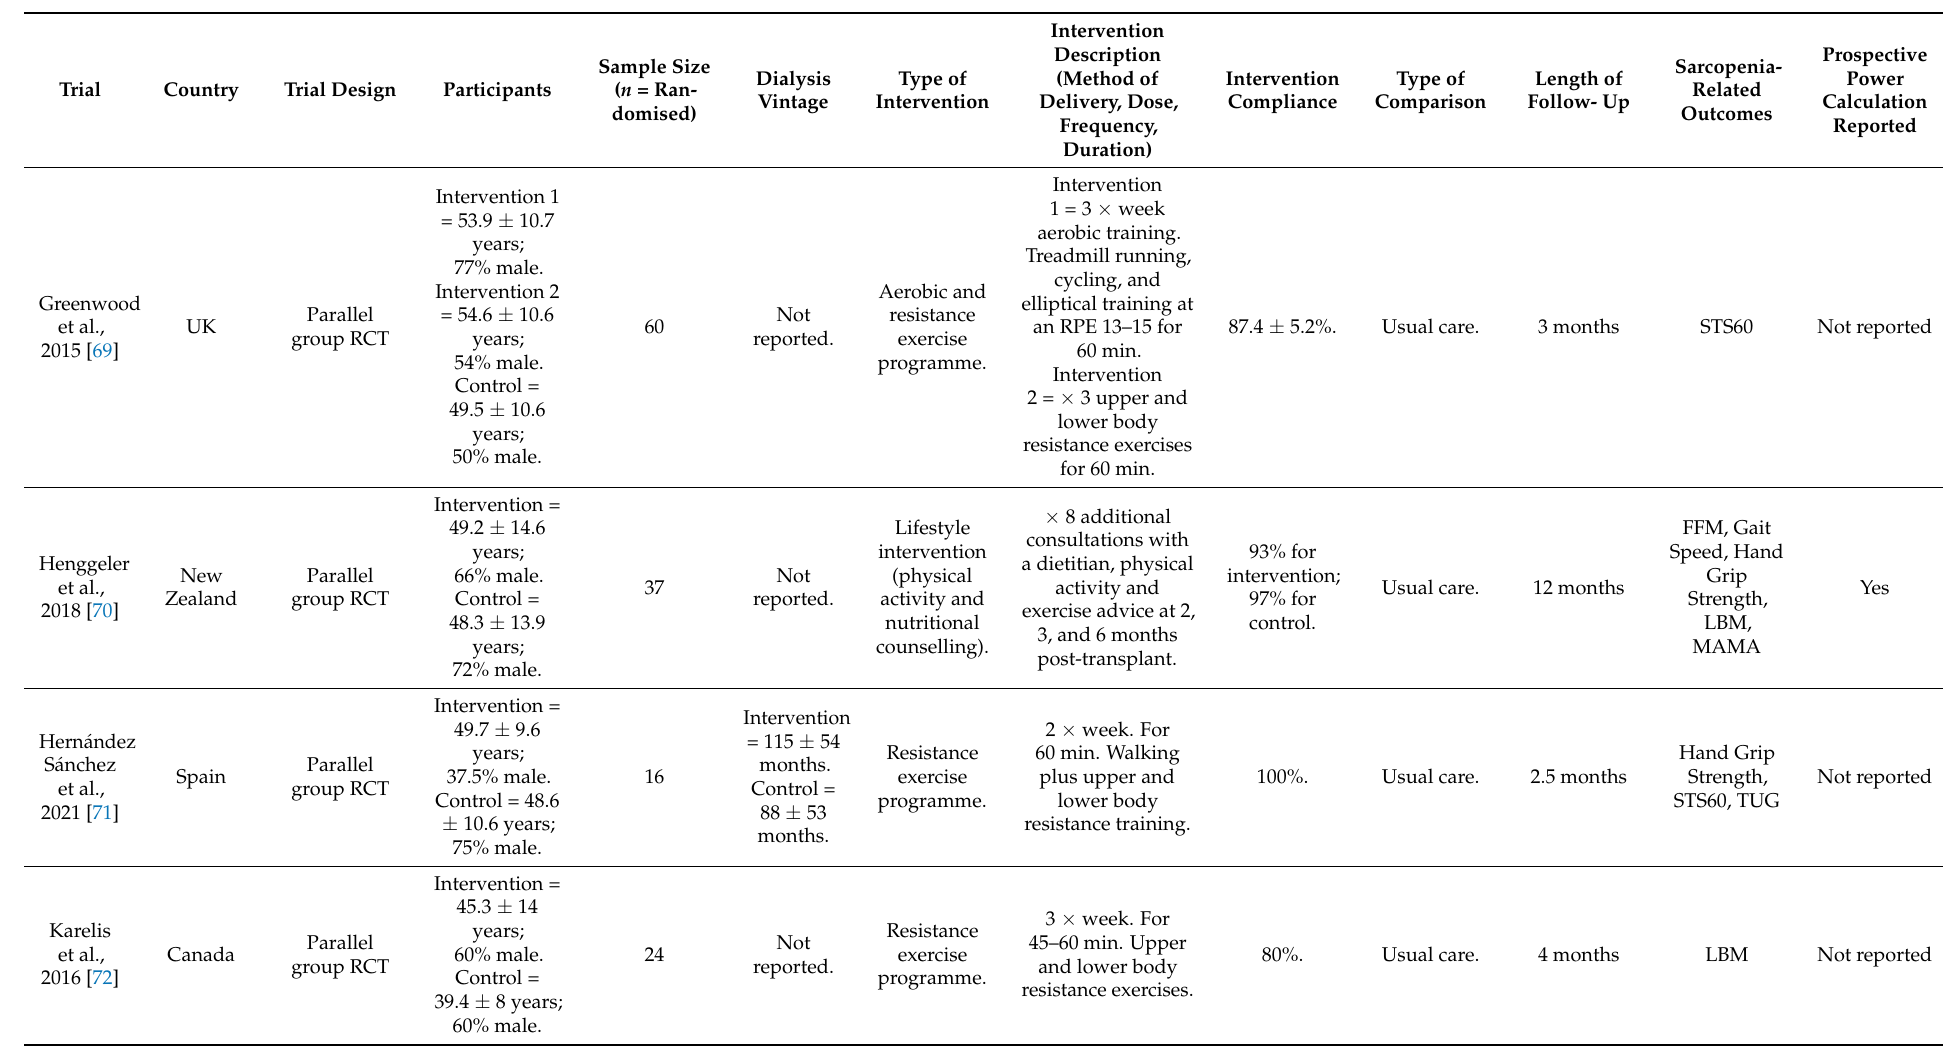
Table 3. Characteristics of trials in the transplant recipient population reporting an outcome associated with